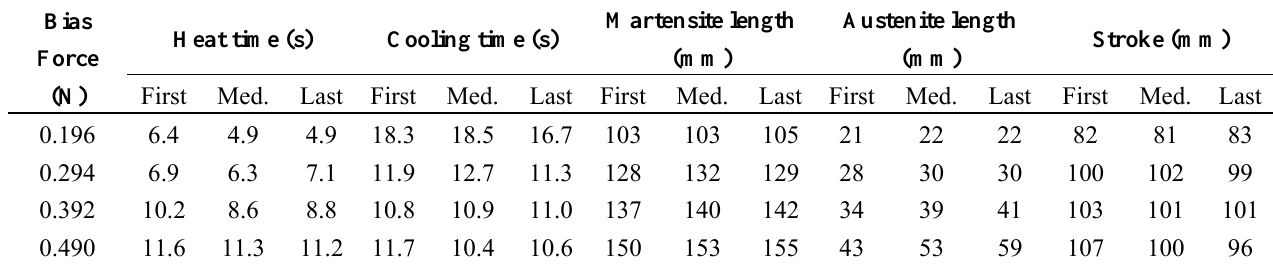
Table 6. The averaged first, median and last values for the bias force manipulation.